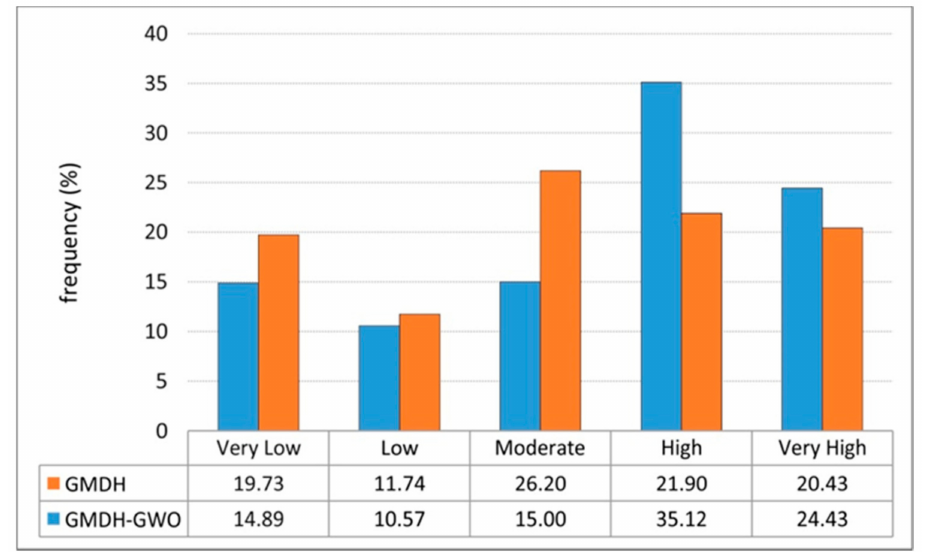
Figure 7. Landslide area percentage in di ff erent susceptibility